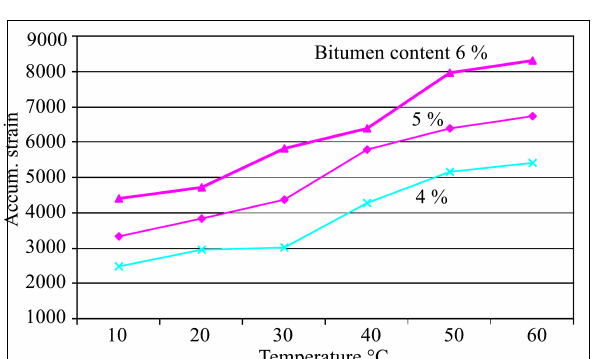
Fig 4. Aggregate gradations for all test series (up-limit and down- limit)